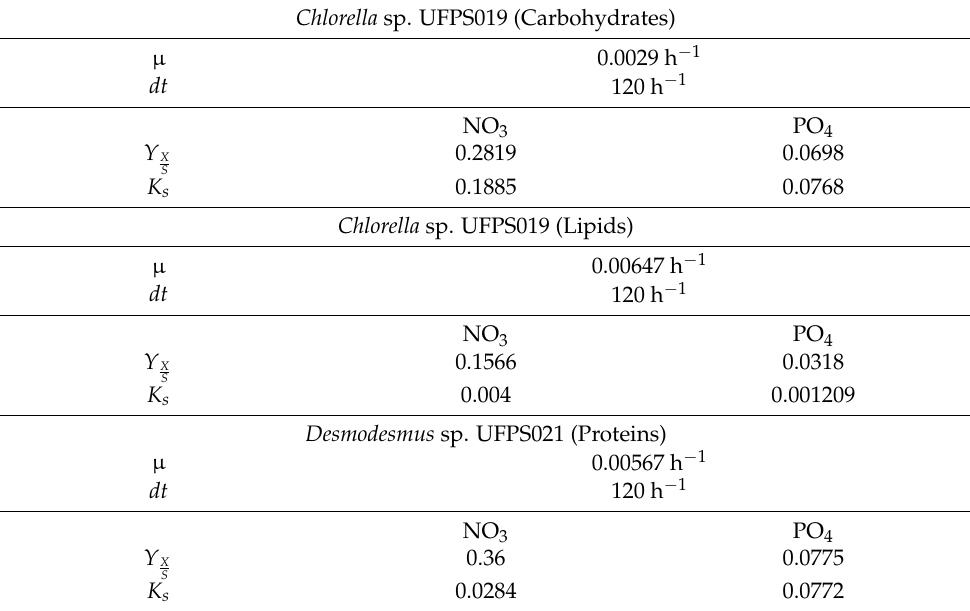
Table 4. Growth parameters for production of carbohydrates, proteins, and